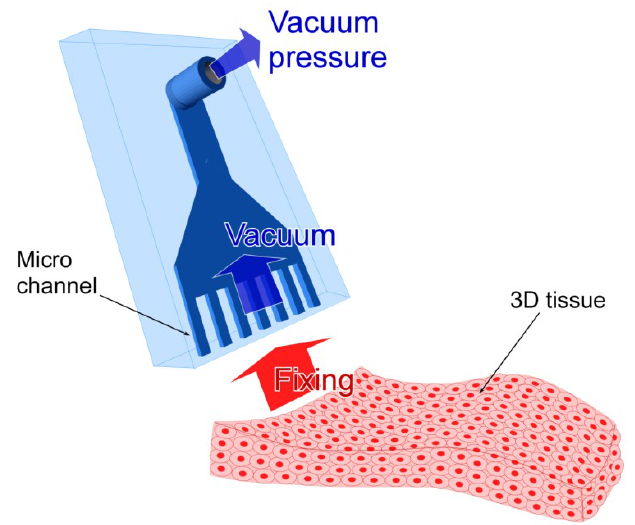
Figure 1. Conceptual illustration of the micro vacuum chuck (MVC). The 3D tissue is suctioned toward the micro size vacuum holes and fixed there by vacuum pressure which is generated at the holes.